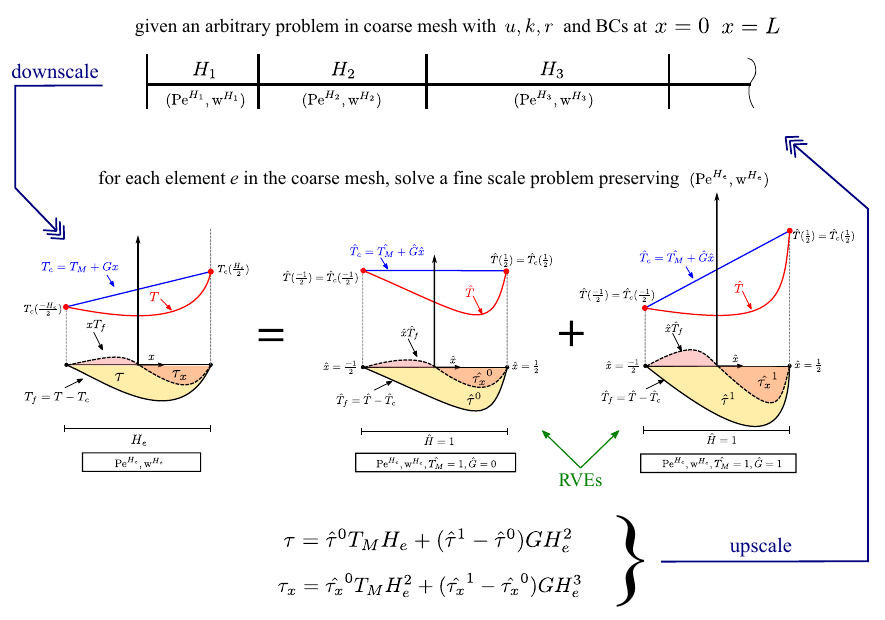
Fig. 2 A graphical description of the general idea in the P-DNS methodology for solving an arbitrary ADR problem. Due to the linearity of the problem, the superposition theorem allows splitting the fine scale into two canonical